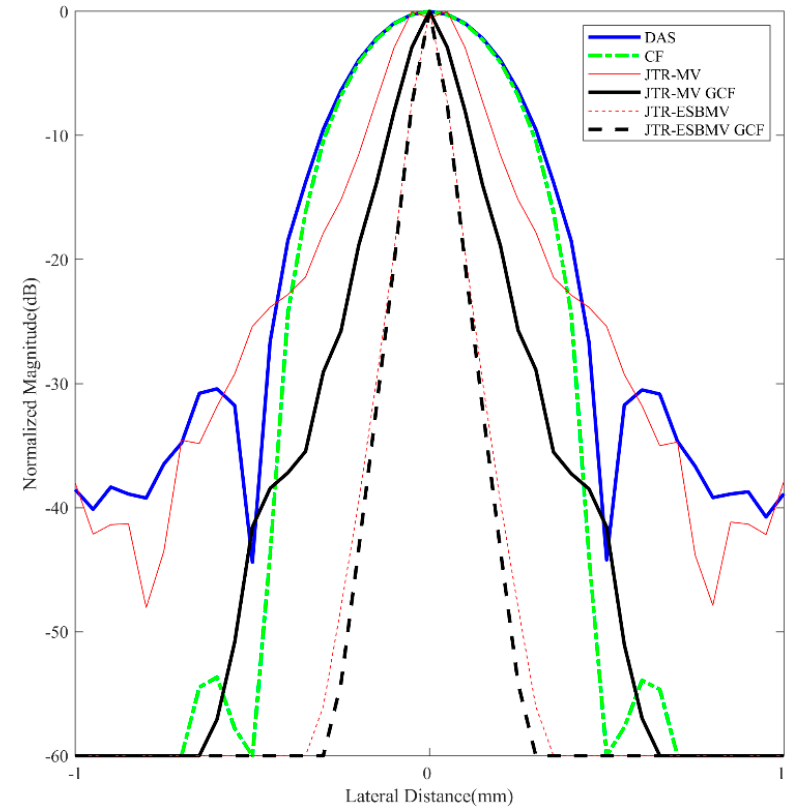
Figure 3. Lateral variations at z = 30 mm in simulated point images.